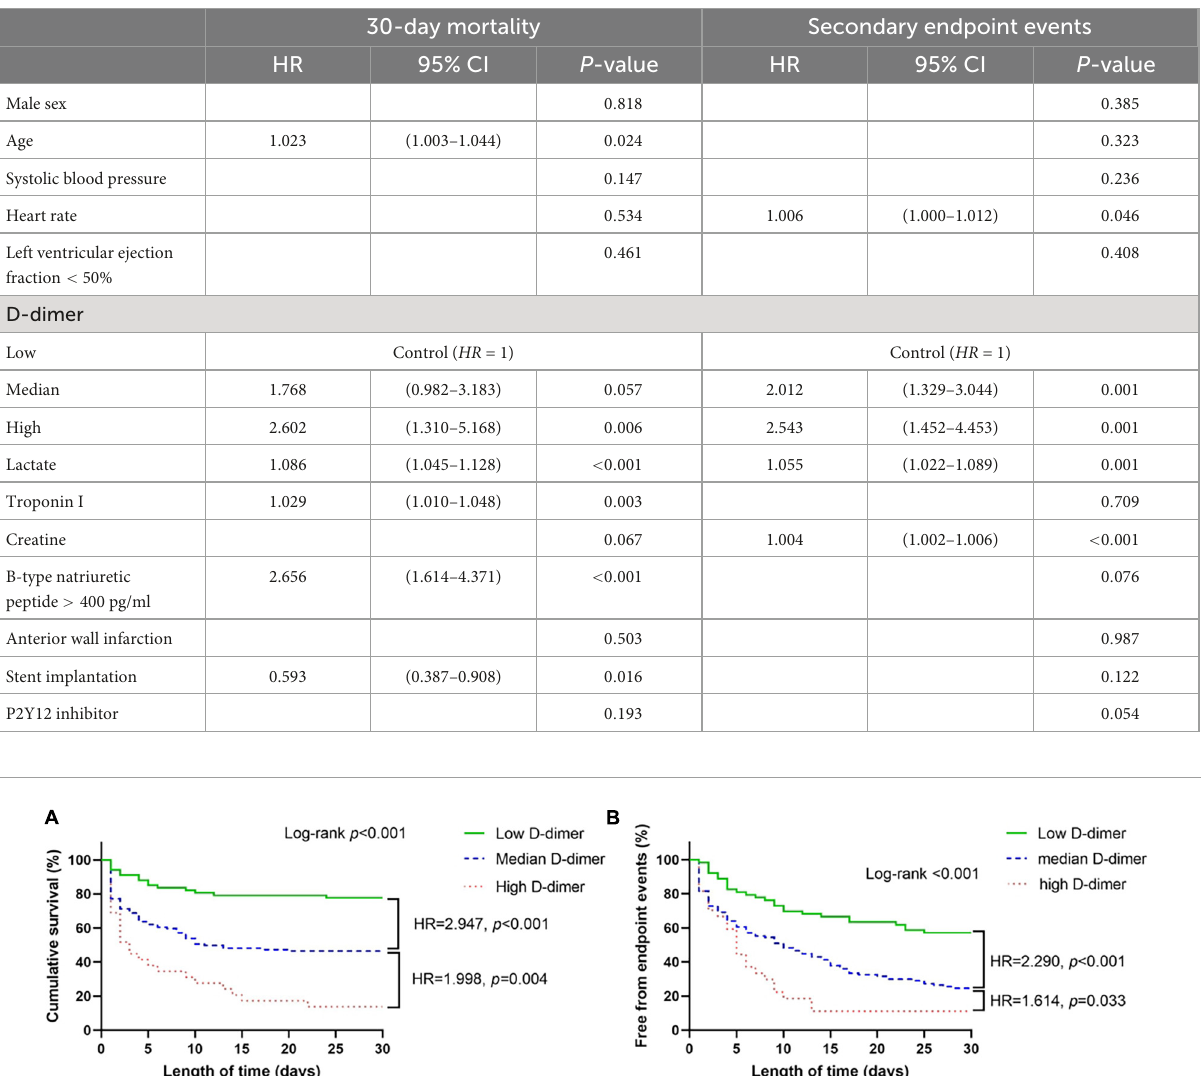
TABLE 4 Multivariable Cox proportional hazard model.